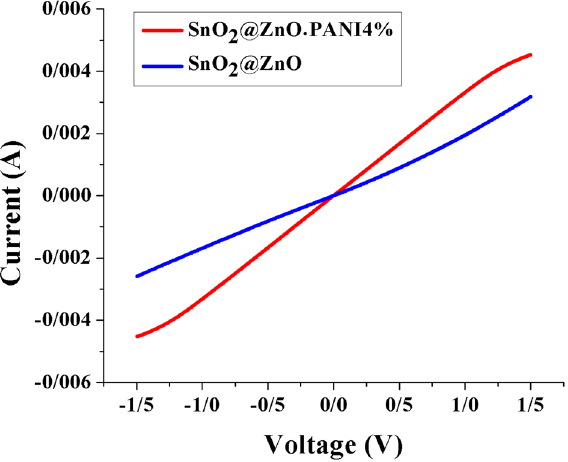
Figure 11. I–V curves of the device with glass/FTO/ETLs/carbon structure.